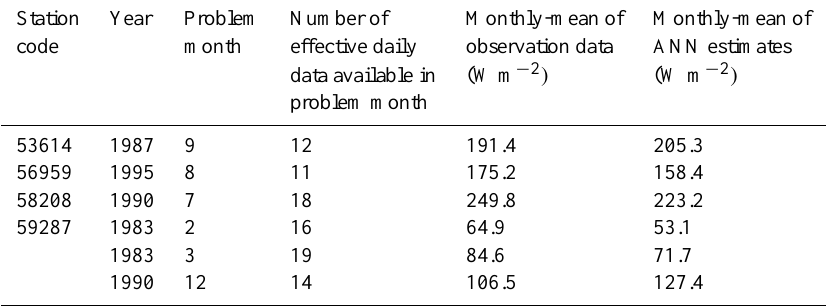
Table 3. Replacement of the radiation data collecting from four additional radiation stations used for trend validation (see the text). Station Year Problem Number of effective